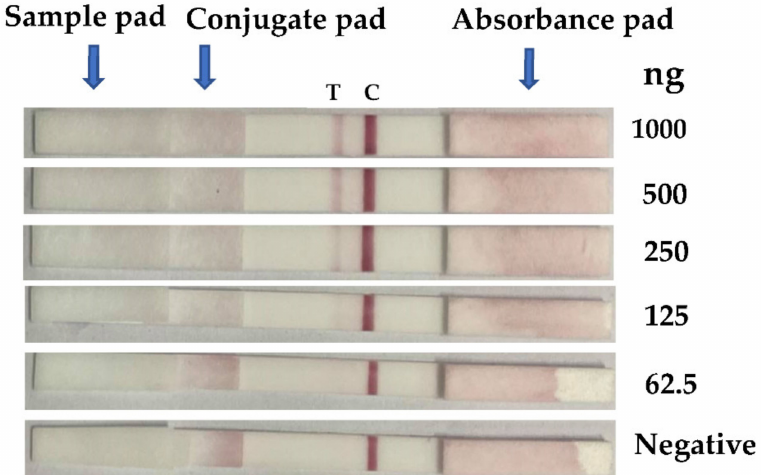
Figure 3. The rGroEL detection limit of the ICT AgTK. Different amounts of rGroEL (62.5–1000 ng) in 10 µ L PBS were applied to the ICT AgTK. Negative was PBS alone. The lowest amount of the rGroEL that could be detected by the test kit was 125 ng. The results of the ICT AgTK were read 5 min after applying the samples. A positive result is seen as two red lines (the left line is the test (T) line, and the right line is the control (C) line); only C shows a negative